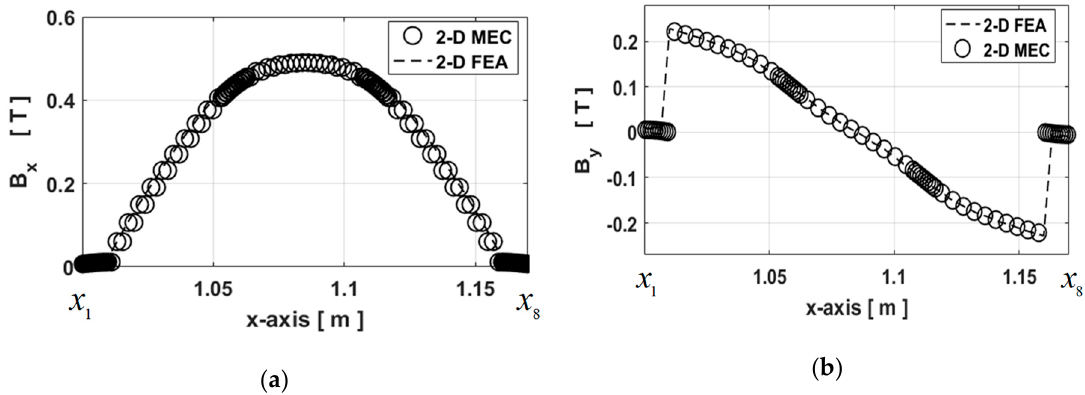
Figure 7. Waveform of B for Path m1 with I max = 7.78A at t = 0s and h mp = 6mm: ( a ) x- and ( b )